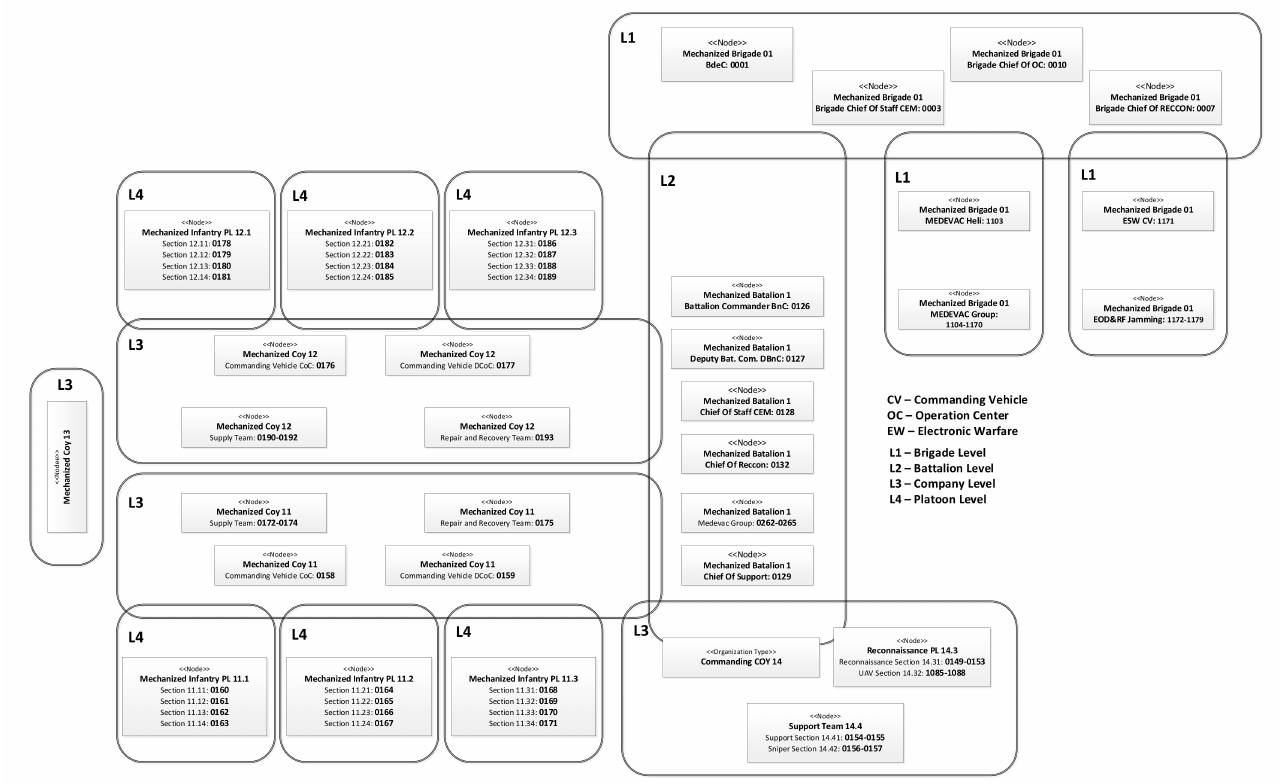
Figure 12. The order of battle for the operational